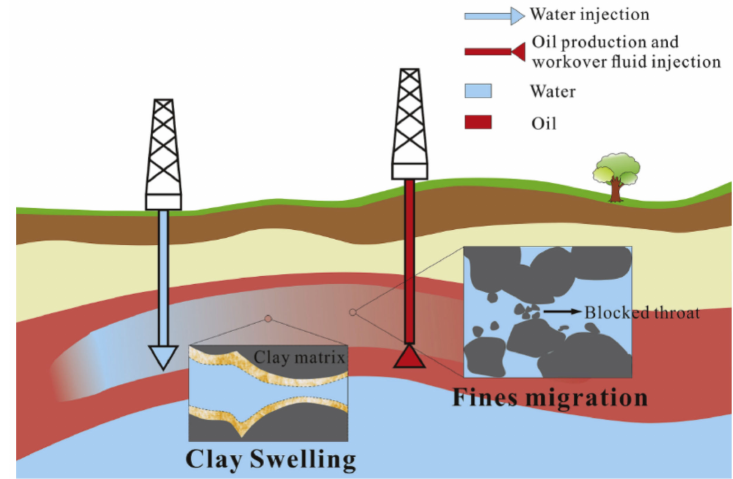
Figure 1. Illustration of permeability alterations caused by swelling of clay and migration of fines near the wellbore region after rock–fluid interaction. Taken from [15].